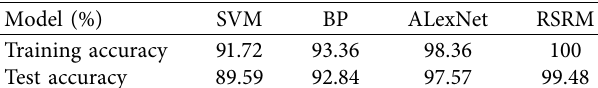
Table 5: The accuracy of different model identification.